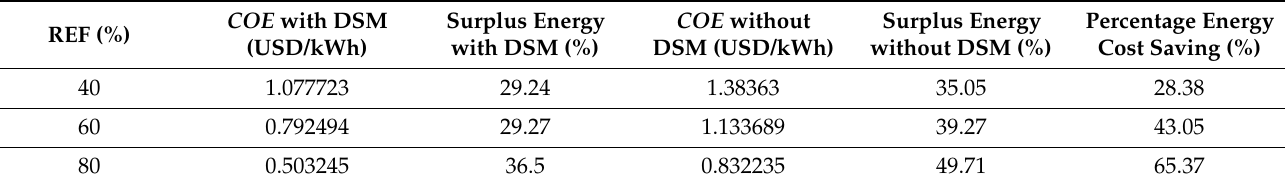
Table 8. Percentage energy cost saving and COE at different REF.